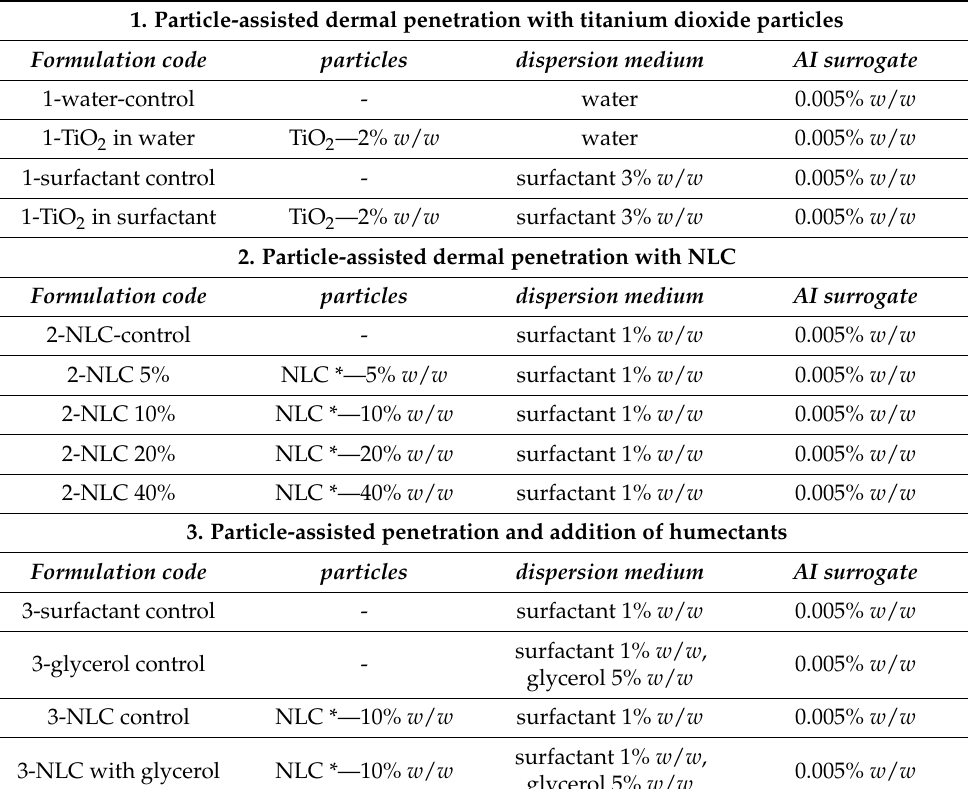
Table 1. Overview of formulations and compositions of the formulations